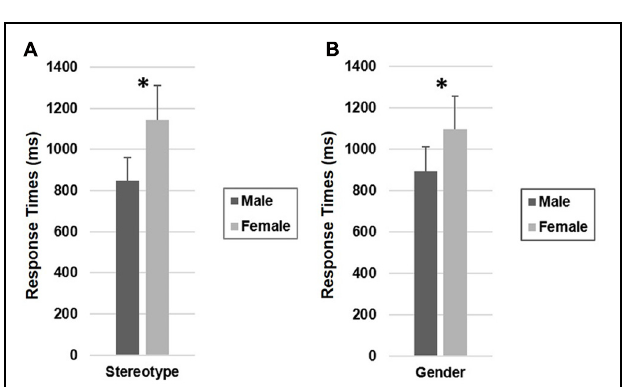
FIGURE 2 | (A,B) Response times as a function of (A) responders’ gender stereotypes and of (B) responders’ genders. Error bars represent standard errors. ∗ p <